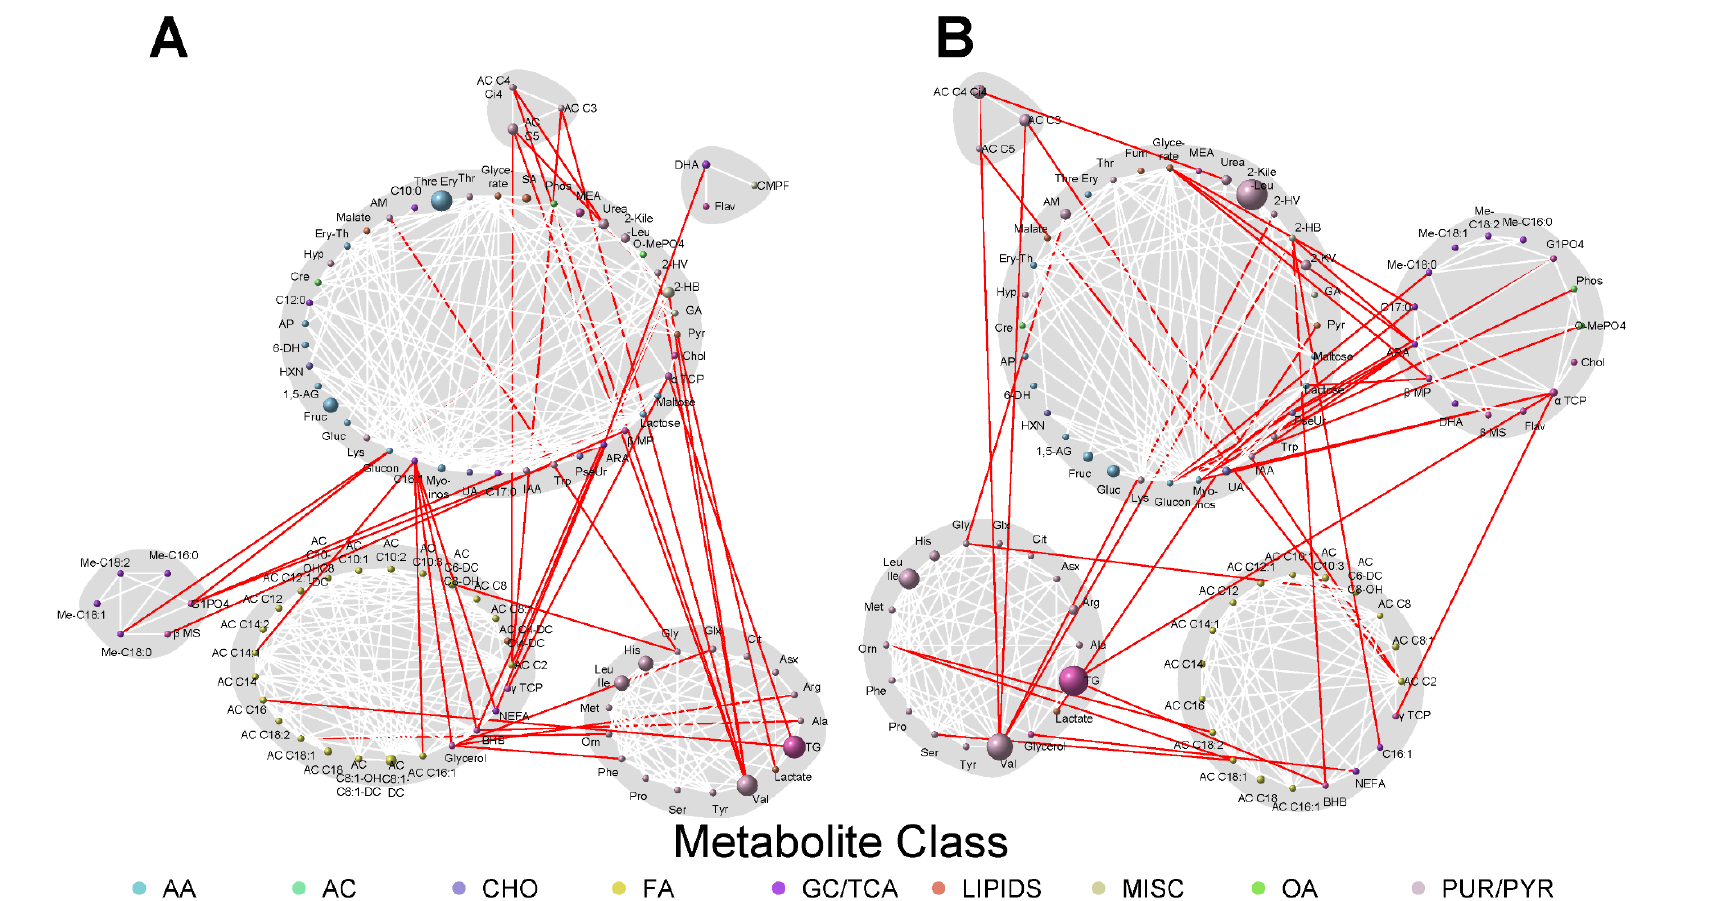
Figure 3. Maternal fasting ( A ) and 1 h ( B ) metabolite networks associated with cord C-peptide. Grey shading represents spin-glass communities within the metabolite networks. The lines between two nodes (edges) represent dependence among metabolite pairs conditional on all other metabolites in the network according to graphical lasso. Red edges represent dependencies for metabolites in different spin-glass clusters and white edges represent dependencies for metabolites within the same spin-glass cluster. The node size of each individual metabolite reflects the strength of the association with each newborn outcome. A larger node size indicates a more robust association. Nodes are colored by metabolite class as described in Figure 1. Metabolites are abbreviated as per the legend for Figure 1.